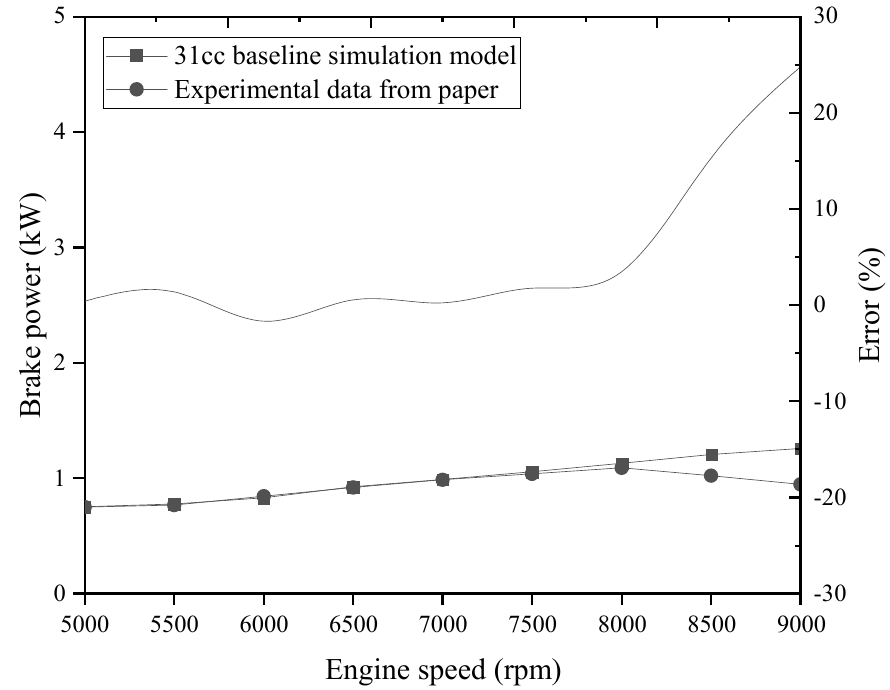
Figure 5. Power curves comparison from experimental results as obtained from the Ricardo WAVE simulation.